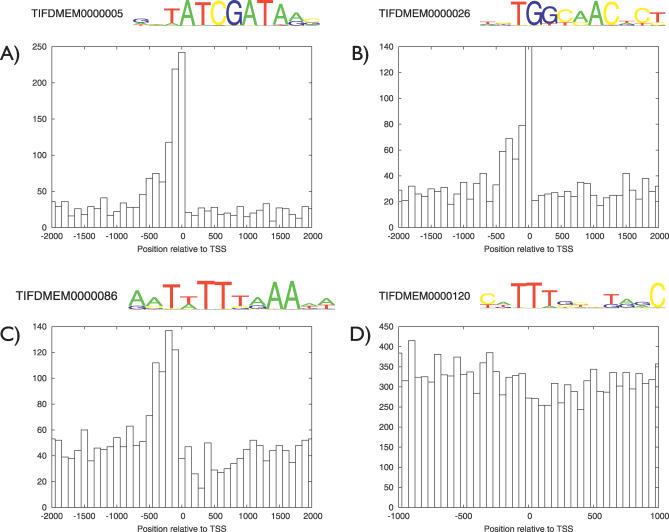
Position Distributions of Matches to Selected Motifs around Transcription Start Sites on Chromosome Arm 2R(A,B) Show strong upstream peaks with different shapes.(C) Shows a broader (but still highly significant) upstream peak and some underrepresentation immediately downstream of the TSS.(D) Shows results for a motif with little or no positional bias.